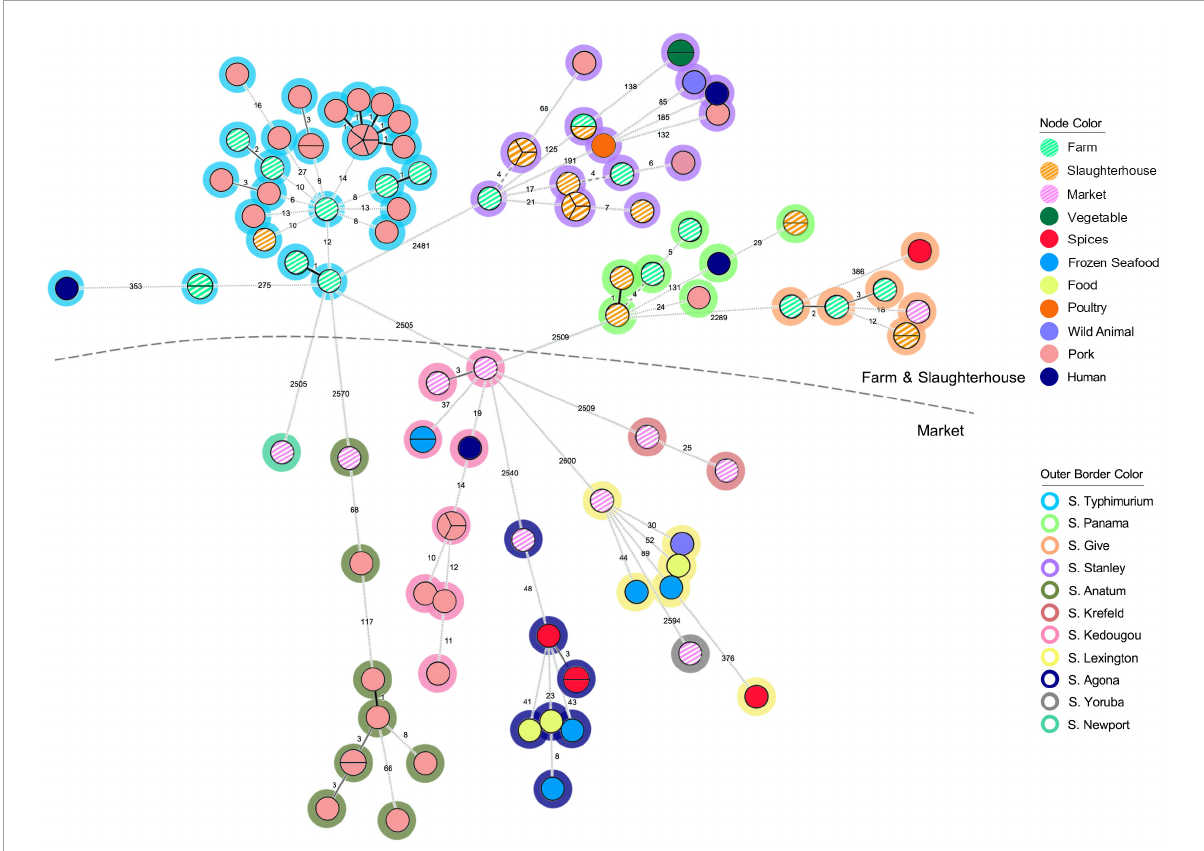
FIGURE2 The minimum spanning tree (MST) analysis of 43 Salmonella isolates recovered from pork production chain (striped nodes) and additional 61 Salmonella isolates circulating in Thailand. Each isolate was grouped according to the loci different of EnteroBase Salmonella database’s cgMLST scheme, which considers a total of 3,002 loci (Pearce et al., 2020). The number on the branch represent the number of loci different between each isolate. Node color coding were representing the sources of the Salmonella isolates. Outer border color represents each serotype of Salmonella